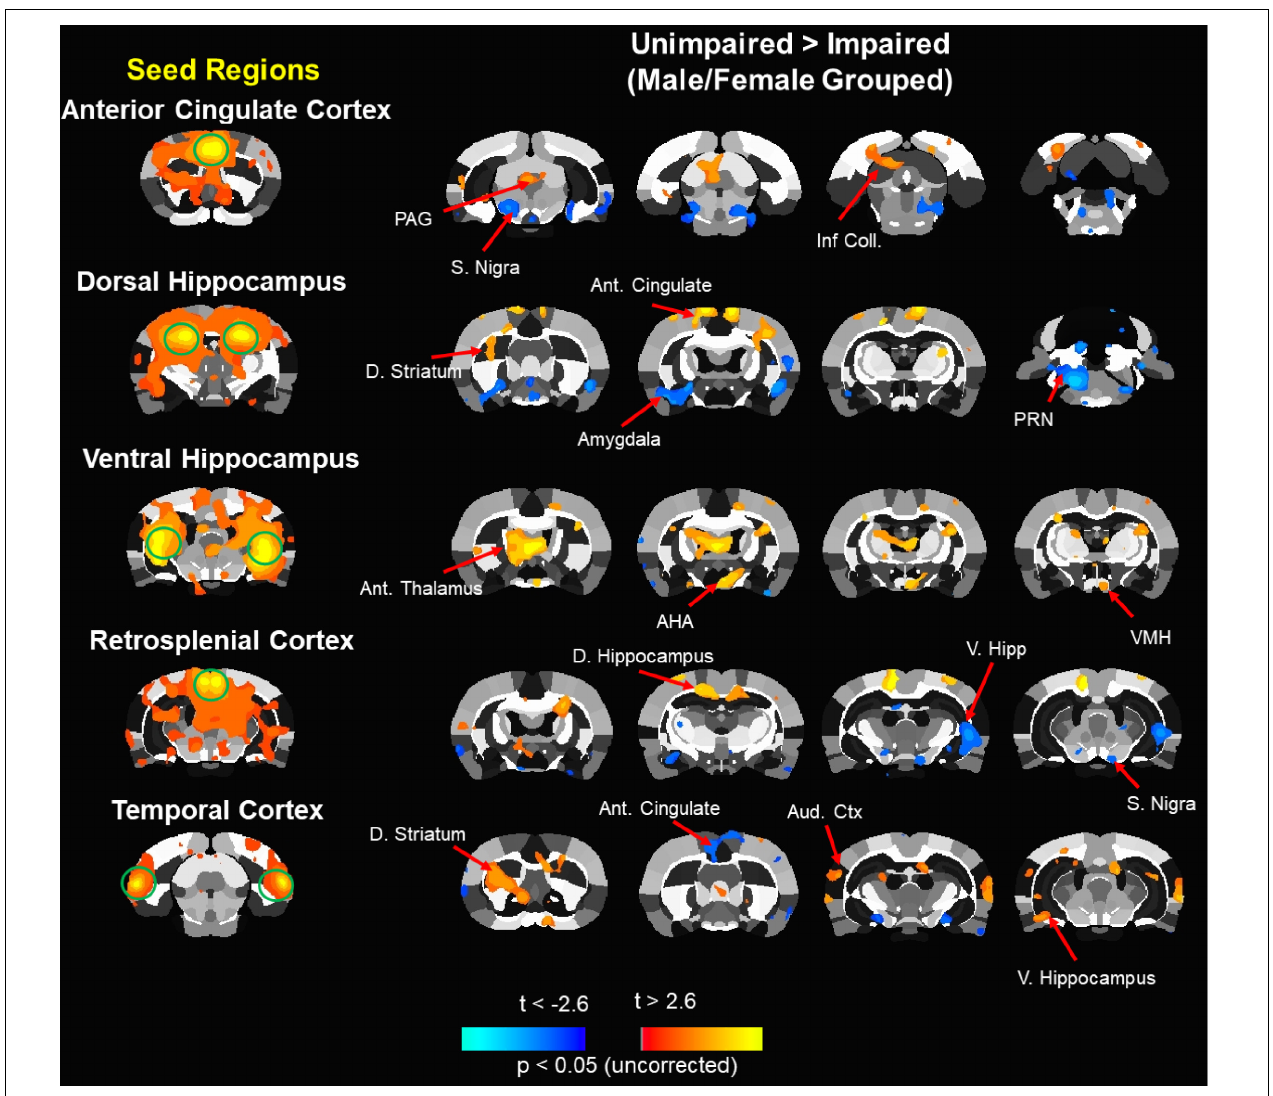
FIGURE 7 | Composite resting state functional connectivity maps for impaired and unimpaired animals. Seed based functional connectivity analysis. Images processed for functional connectivity are overlaid onto a segmented atlas of the rat brain with a threshold of p < 0.05. Column on the left shows the seed regions. To the right, in each row, are maps indicating areas that showed a significant reduction in functional connectivity (blue) or increases in functional connectivity (red/yellow) in impaired vs. unimpaired. Ant, anterior; AHA, anterior hypothalamic area; D, dorsal; Inf. Coll, inferior colliculus; PAG, periaqueductal gray; PRN, pontine reticular nucleus; S. Nigra, substantia nigra; V, ventral; VMH, ventromedial